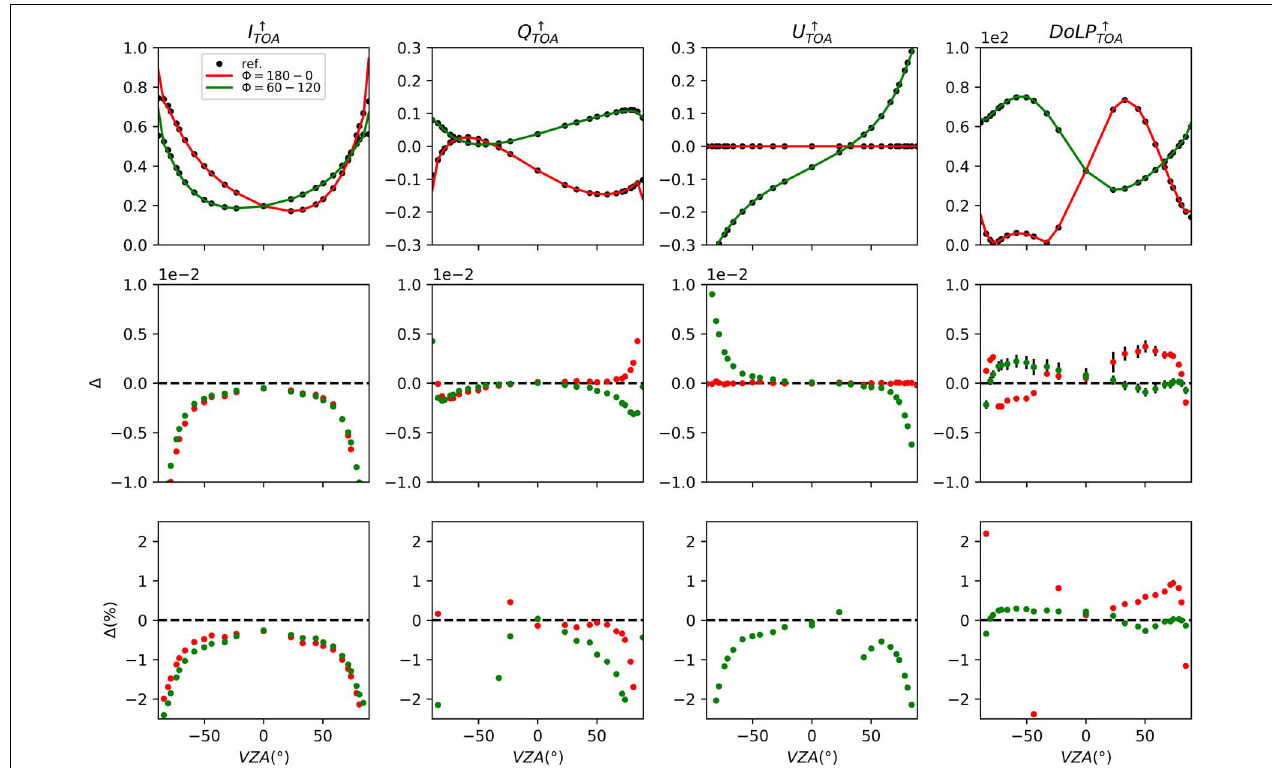
FIGURE 14 | Same as Figure 13 , but spherical-shell atmosphere for Monte Carlo code. The effect of sphericity is to lower intensity I by 0.3–0.5% for viewing angles θ < 50 ◦ and up to 2% at larger viewing angles, and to change polarization ratio DoLP by